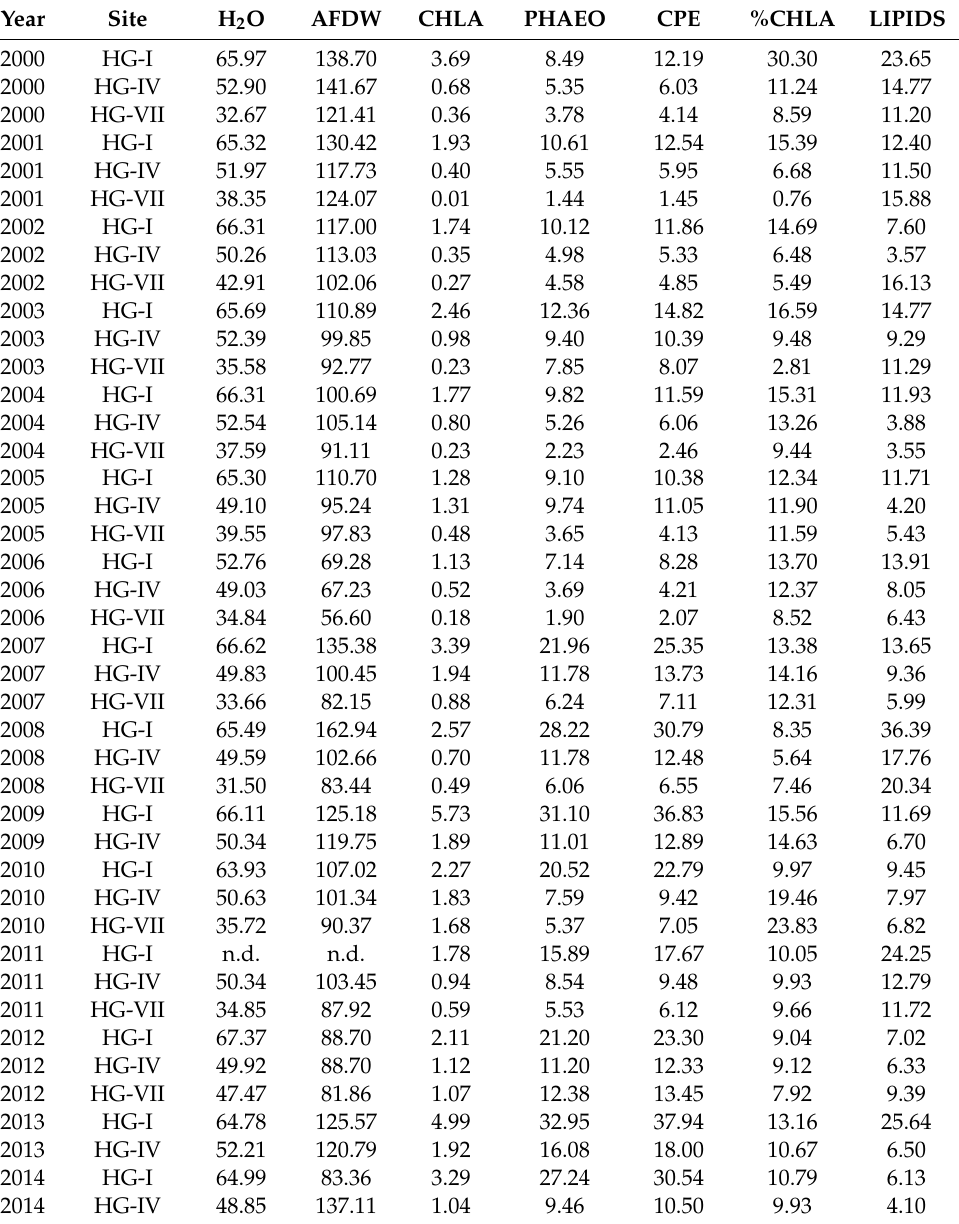
Table 5. Background parameter: mean values for the uppermost 5 cm of the sediments (H 2 O: